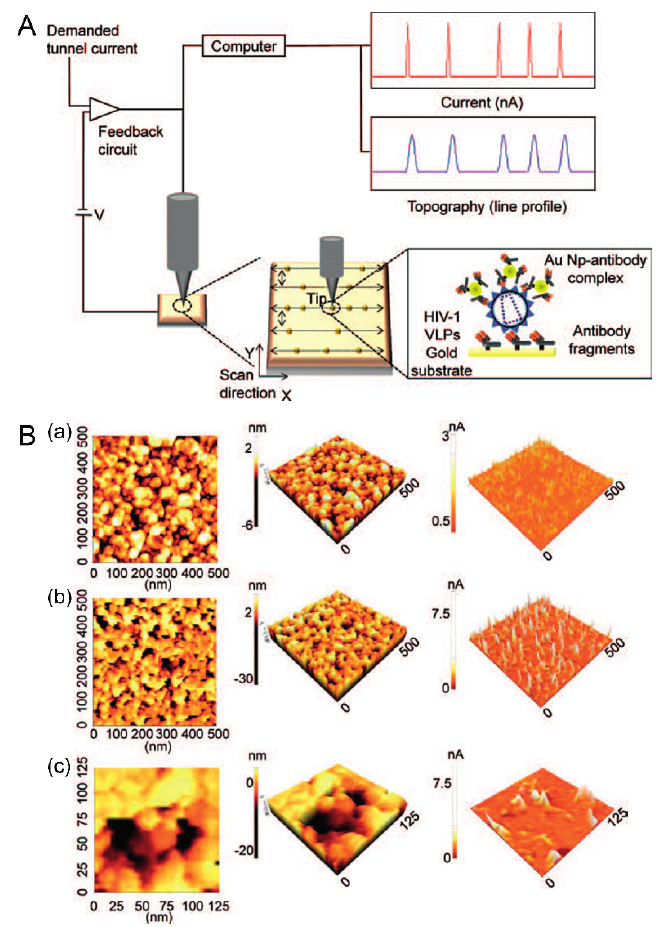
Figure 1. Vertical configured electrical detection system for HIV-1 virus. ( A ) Schematic diagram of an electrical detection system based on STM and its topography and the tunneling current profile of dispersed Au nanoparticle-antibody complexes based on immunoreactions; ( B ) Topographic images and current profile of: ( a ) bare gold surface and ( b , c ) biosurface fabricated with localized fragment antibody/target (HIV-1 VLPs)/Au nanoparticle-antibody complex. Figure reproduced with permission from [20], © 2014 American Scientific